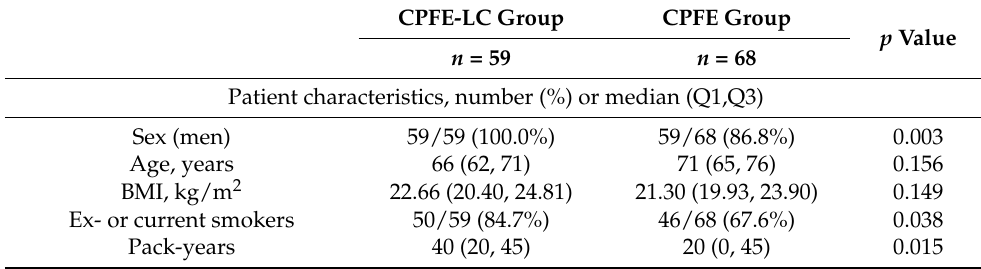
Table 2. Clinical characteristics and imaging features in CPFE patients with and without lung